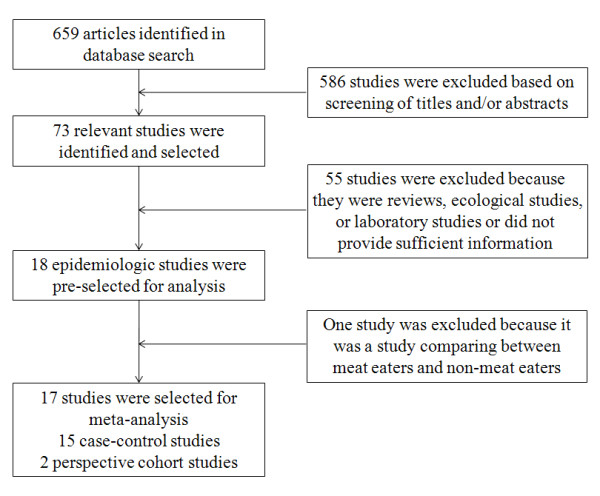
Flowchart of Selection of Studies for Inclusion in Meta-analysis.